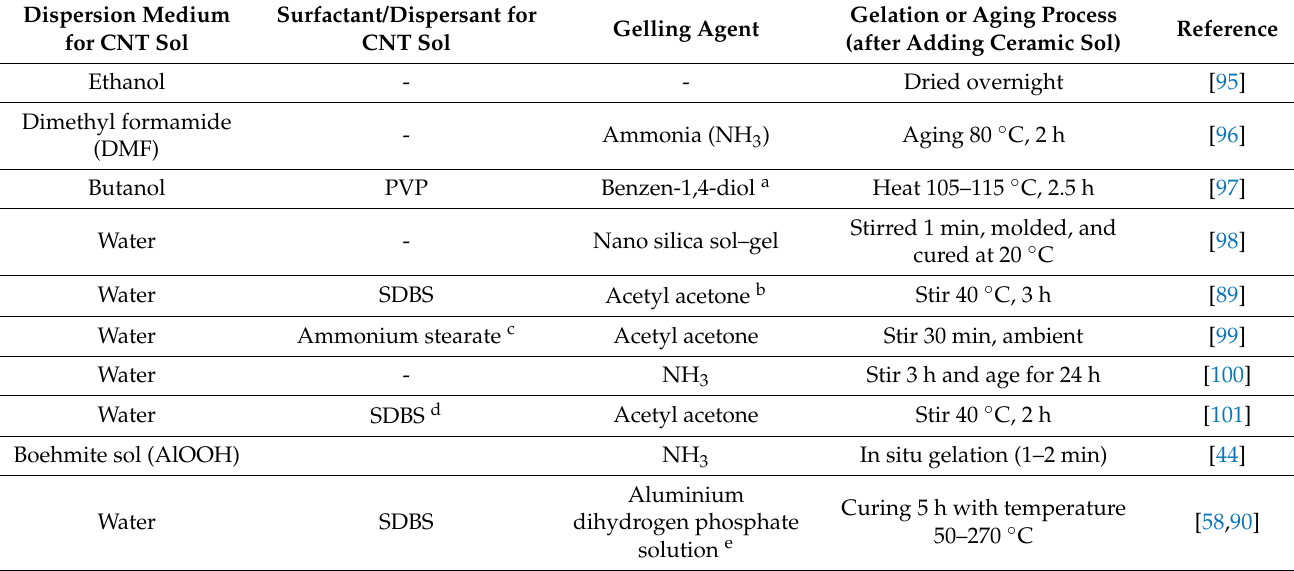
Table 2. The dispersion medium and dispersant of CNT sol, and the CNTs-CMCs gelling agent and gelation process. Dispersion Medium